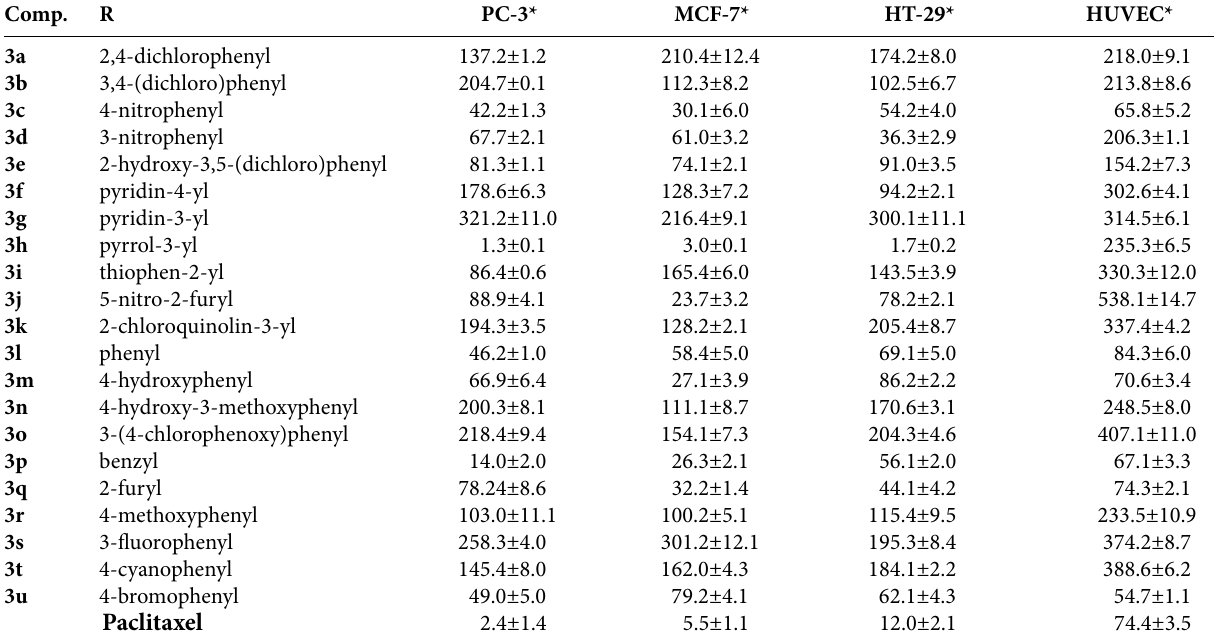
Table 1 . The IC 50 values of synthesized compounds.